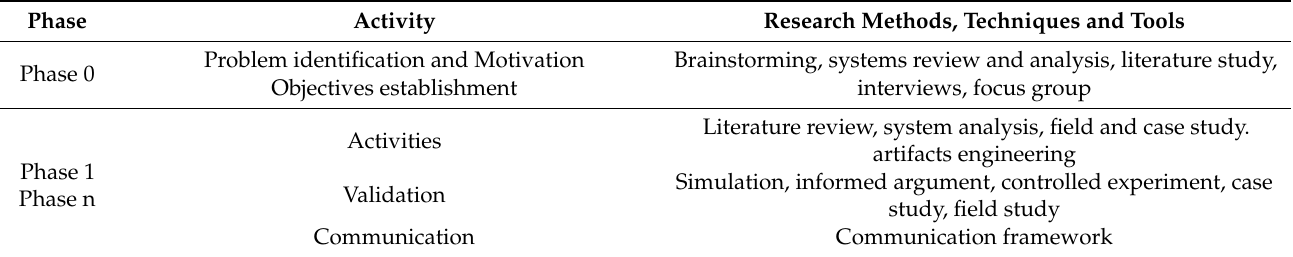
Table 1. DSR process. Research methods, techniques and tools.